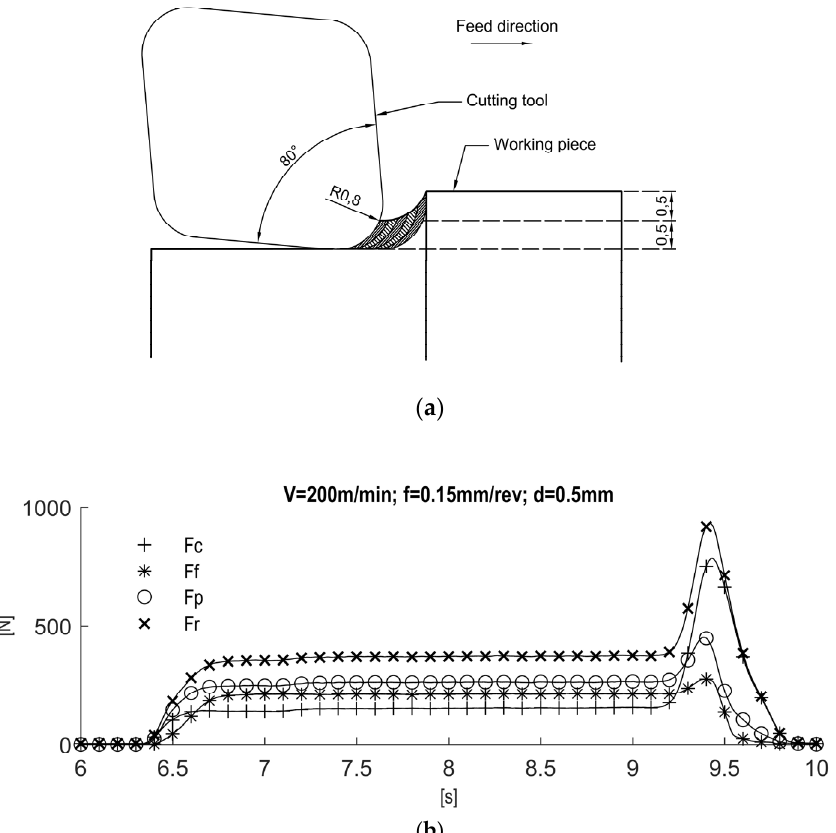
Figure 2. ( a ) Chip section increase at the end of a straight turning pass; ( b ) Force evolution for a test performed at a cutting velocity of 200 m/min, a feed of 0.15 mm/rev, and a cutting depth of 0.25 mm with the CBN170 grade tool.